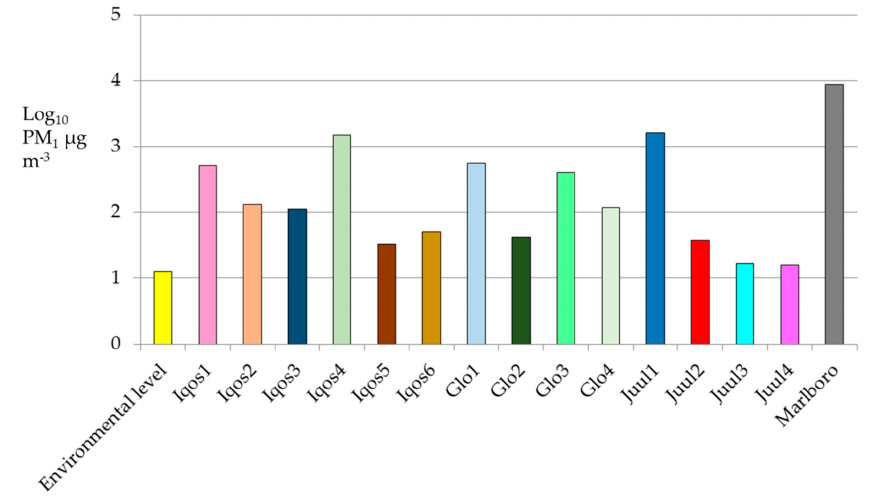
Figure 2. Mean levels of PM with an aerodynamic diameter smaller than 1 µm ( PM 1 expressed as Log 10 PM 1 ) measured during each experiment.